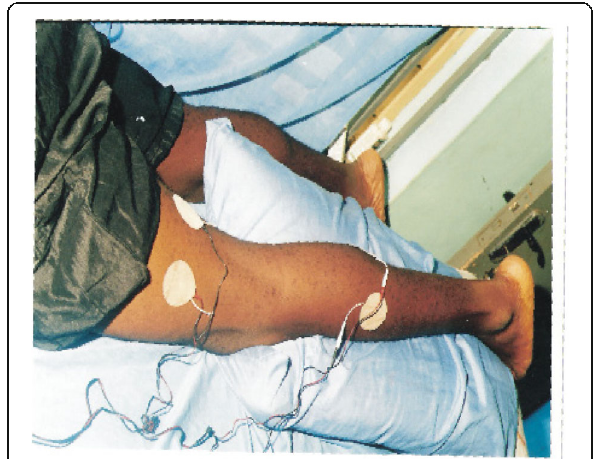
Fig. 2 Showing the second tens electrode placement of on the same subject. The electrode was placed in such a way to cover the area of pain perception. Treatment lasted for 20min and electrode placement was changed to reflect what is obtained in Fig. 3